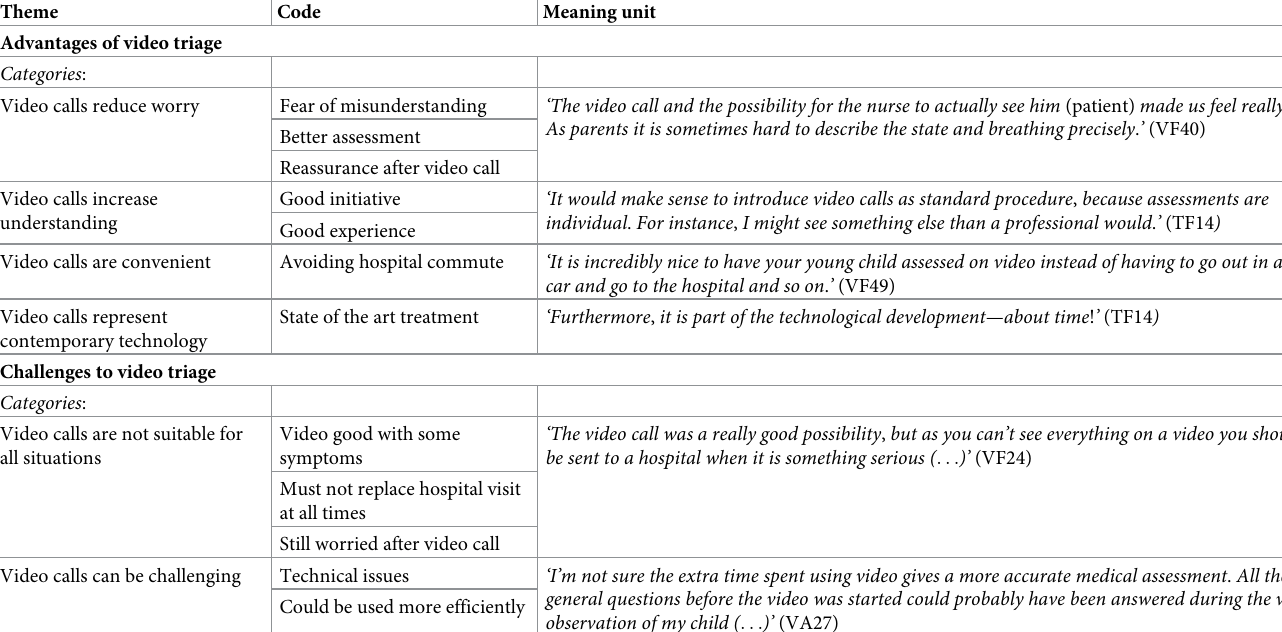
Table 2. Parents’ experience of video triage.